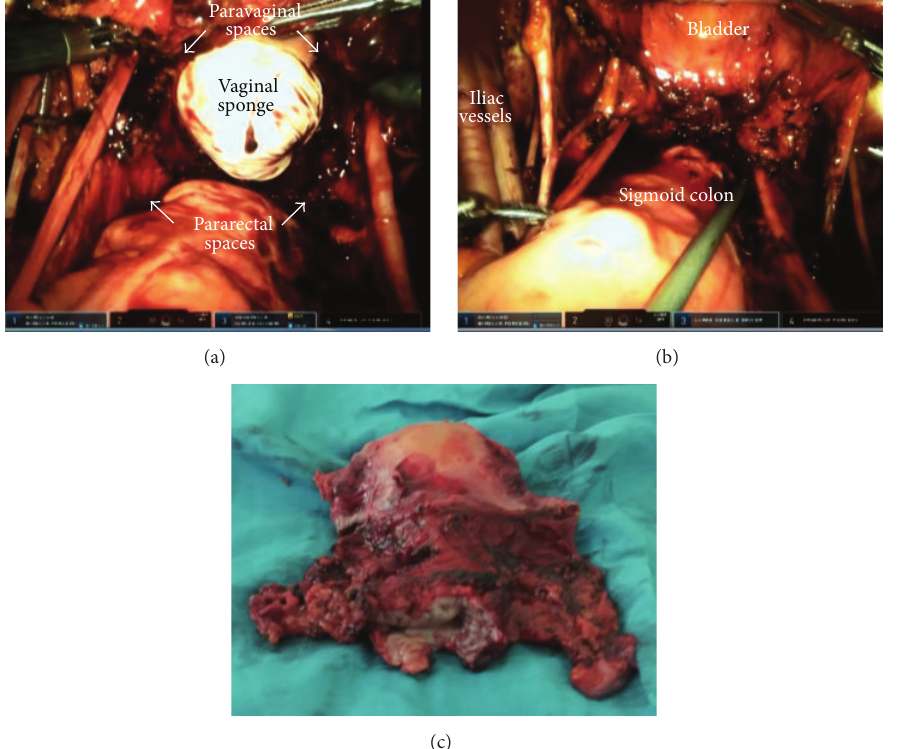
Figure 4: ((a), (b)) Final view of the pelvis after total mesometrial resection. (c) Surgical